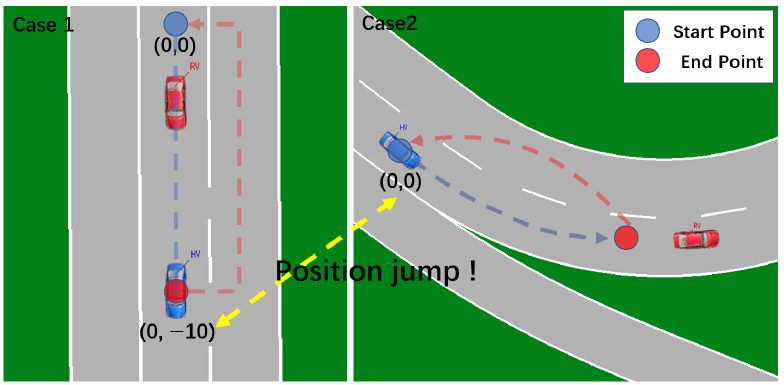
Figure 29. Test case switching causes OBU “Cold start” and solution in VTD